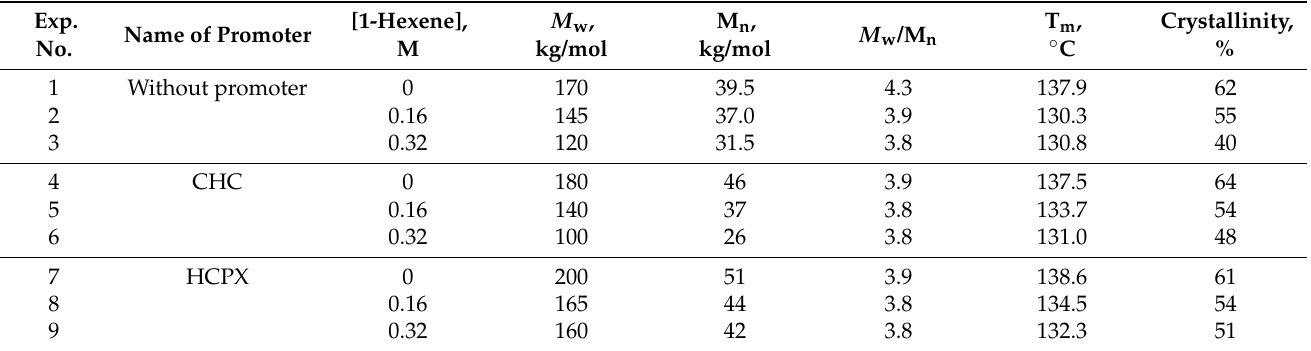
Table 5. The molecular and thermal properties of polyethylene samples produced over TMC/TIBA catalyst (without a promoter and in the presence of CHC and